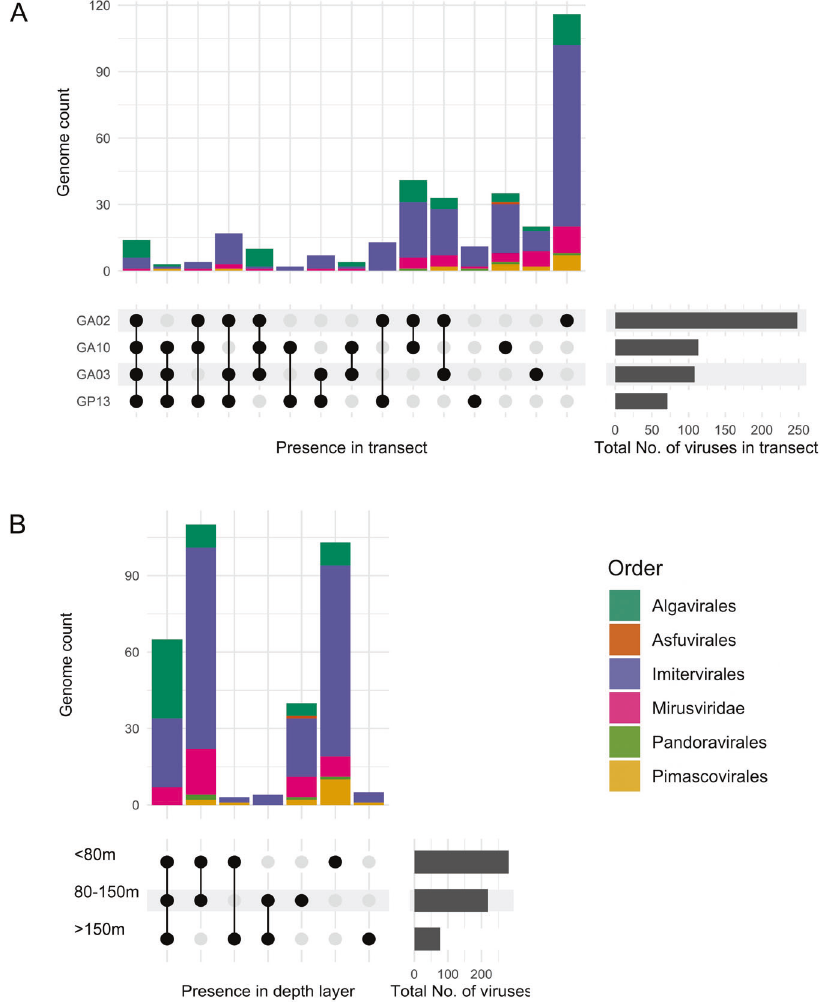
Fig. 2 Unique genomes and genomes shared across different transects and depth strata. The bar graphs show the intersections of genome distribution between the four transects ( A ) and water depth layers ( B ). Horizontal bars (right) indicate the total number of genomes found in each transect; black dots indicate the presence in one or multiple transects; the corresponding vertical bars indicate the number of genomes with the presence described by the